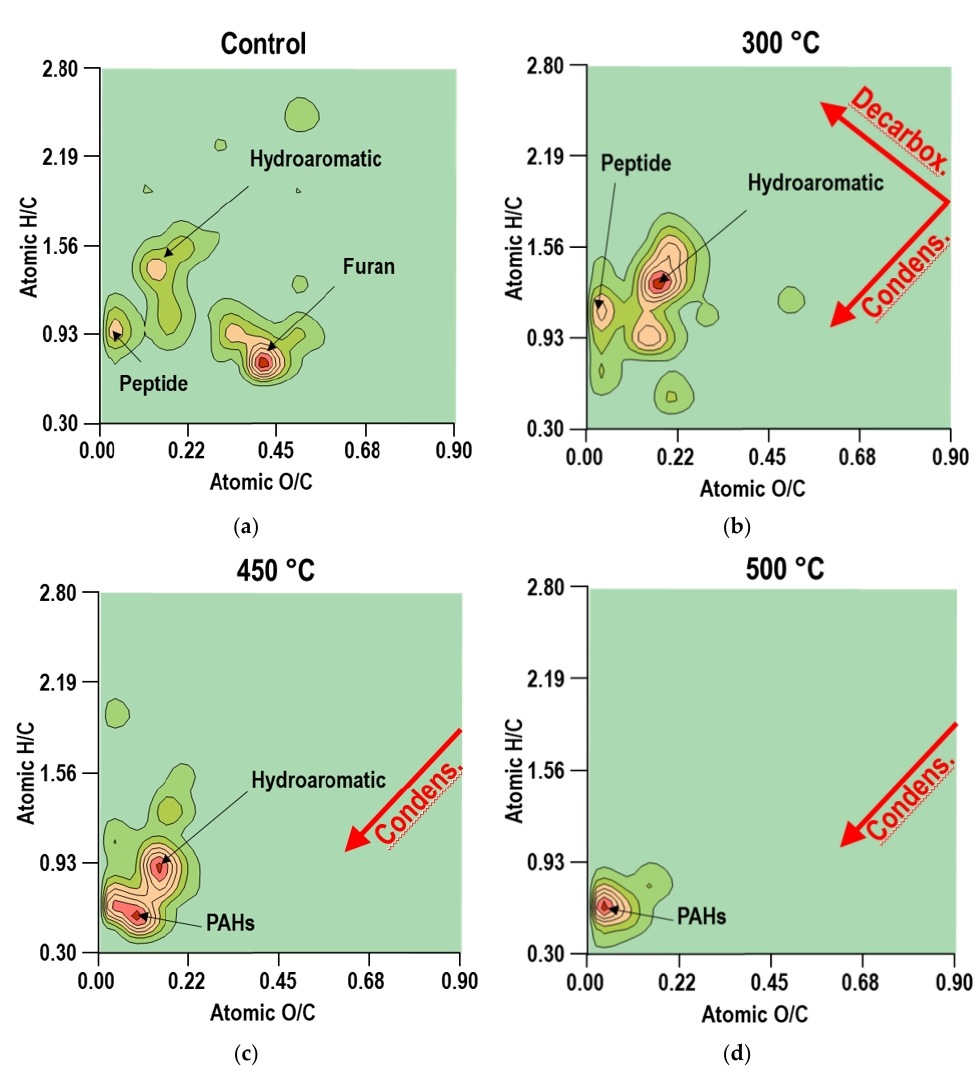
Figure 5. Van Krevelen diagrams representing the evolution of atomic ratios H/C and O/C at different temperatures of heating: unheated control ( a ), heated at 300 ( b ), 450 ( c ), and 500 °C ( d ).